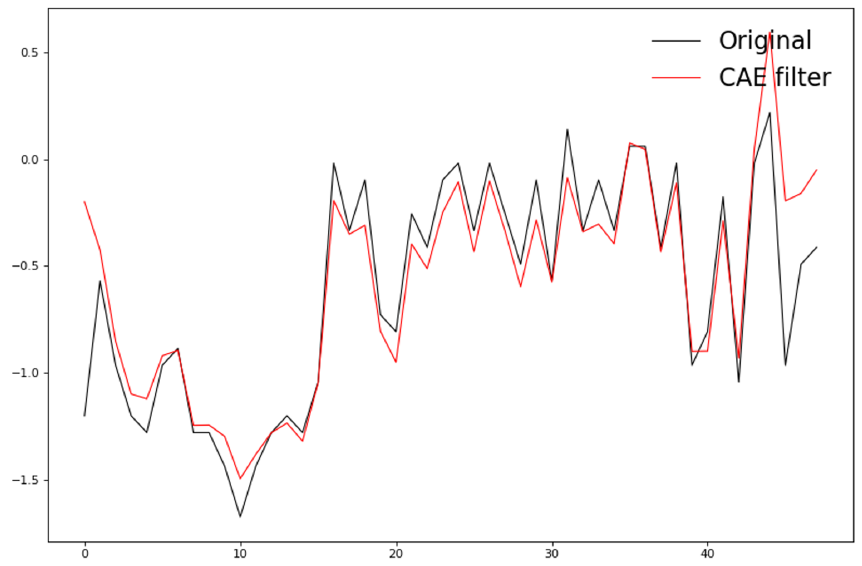
Figure 2. Example of CAE based filter